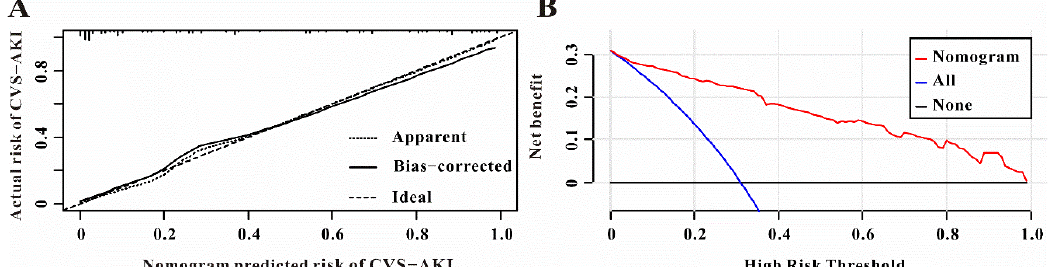
Figure 7. Calibration and clinical utility of the predictive nomogram. ( A ) The predictive nomogram exhibited a high correlation between the actual probability and predicted probability for CVS−AKI. ( B ) Decision curve analysis for the predictive nomogram to predict CVS−AKI in this study.